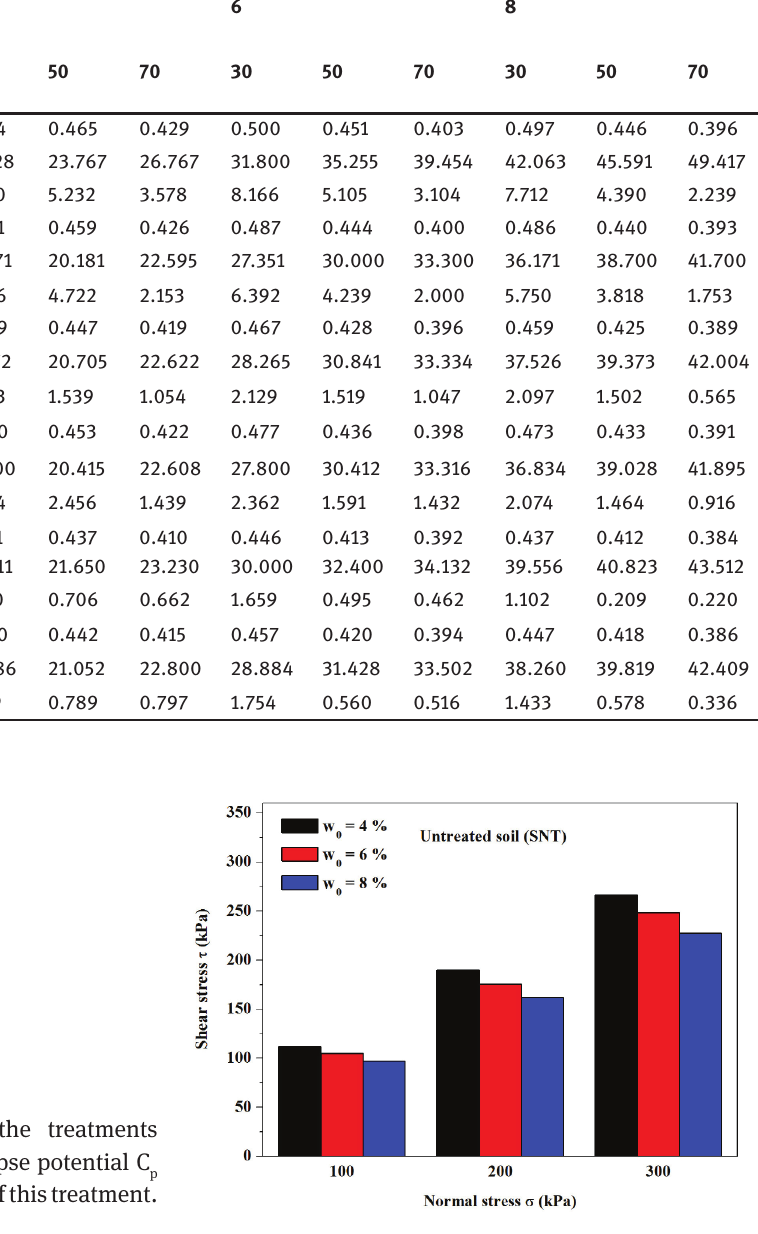
Table 5: Variation of the collapse potential C Type of soils